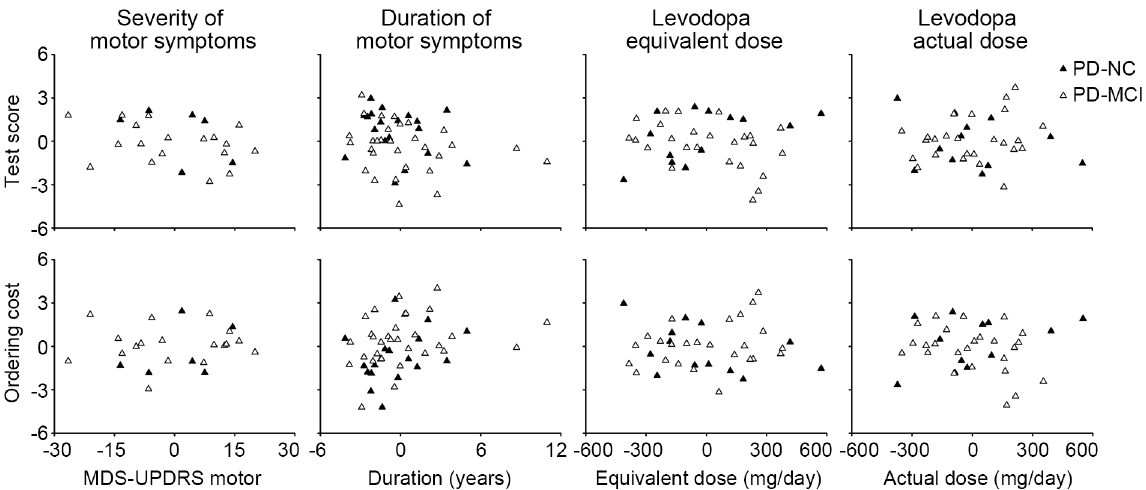
Fig 2. Lack of correlation between individual patients’ task performance and clinical data. Test scores and ordering costs were from the DOT-A. The values were mean-corrected and age-/education-adjusted.